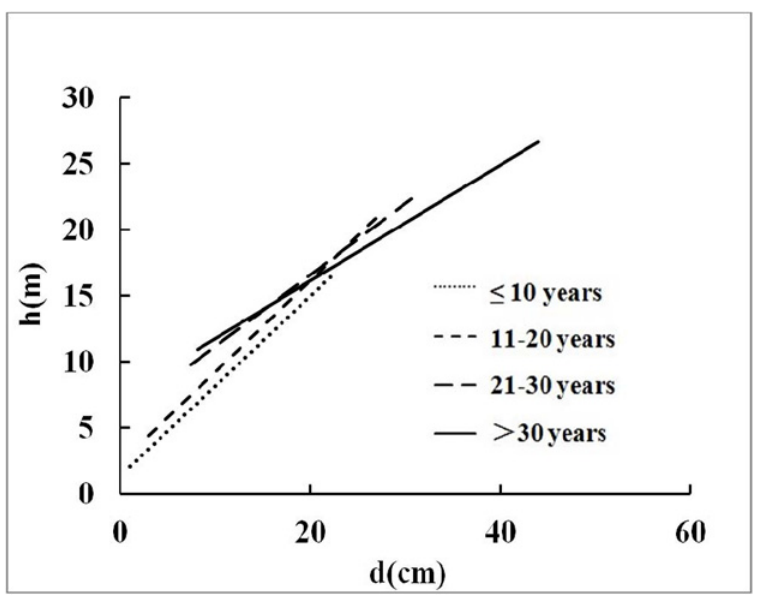
Fig 3. The linear trend line of height-dbh for different ages.